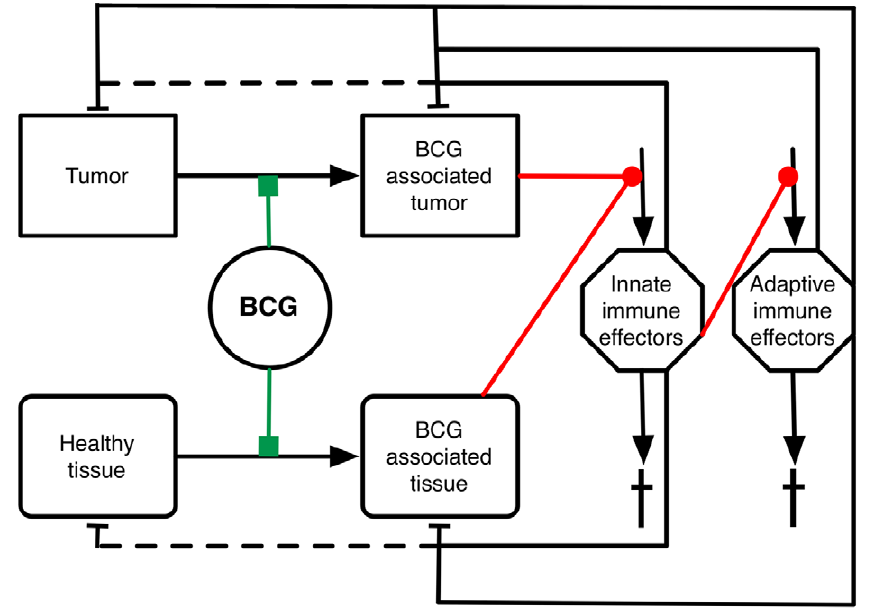
Figure 1. Simplified diagrammatic representation of our mathematical model. The dynamic model represents the interaction between healthy urothelial tissue, tumor cells, and their association with BCG (interaction depicted by green line), which in turn results in the generation of BCG-associated healthy tissue and tumor cells. The latter cell populations possess the capacity to trigger the activation of innate immune effector cells and in turn the priming of adaptive immune effector cells. Red lines ending in circles indicate the input stimuli that influence the recruitment of the indicated immune cell populations. Black arrows indicate either increase (e.g., recruitment or proliferation) or decrease (e.g., death or cell turn- over) of the respective cell population. Lines with blunt ends indicate direct killing of target cell populations (solid lines) or bystander death (dashed lines). The model was parameterized using available clinical and in vivo data and tuned to achieve 50% probability of tumor extinction after six weekly intravesical instillations of BCG. A more detailed version of this figure is provided by the Figure S1 of the supplemental material.